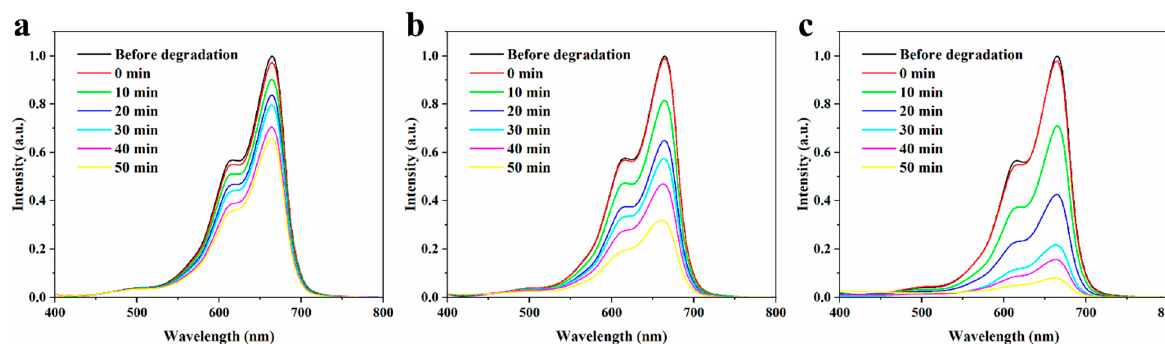
Figure 6. UV-Vis absorption spectra of MB in the presence of ( a ) ZnS, ( b ) Ag 2 O, and ( c ) ZnS/Ag 2 O composite recorded at different time during the photocatalytic tests.